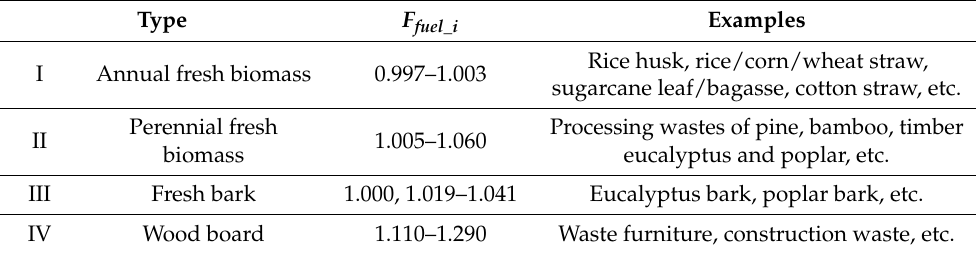
Table 1. Categories and correction coefficients of common biomass fuels.